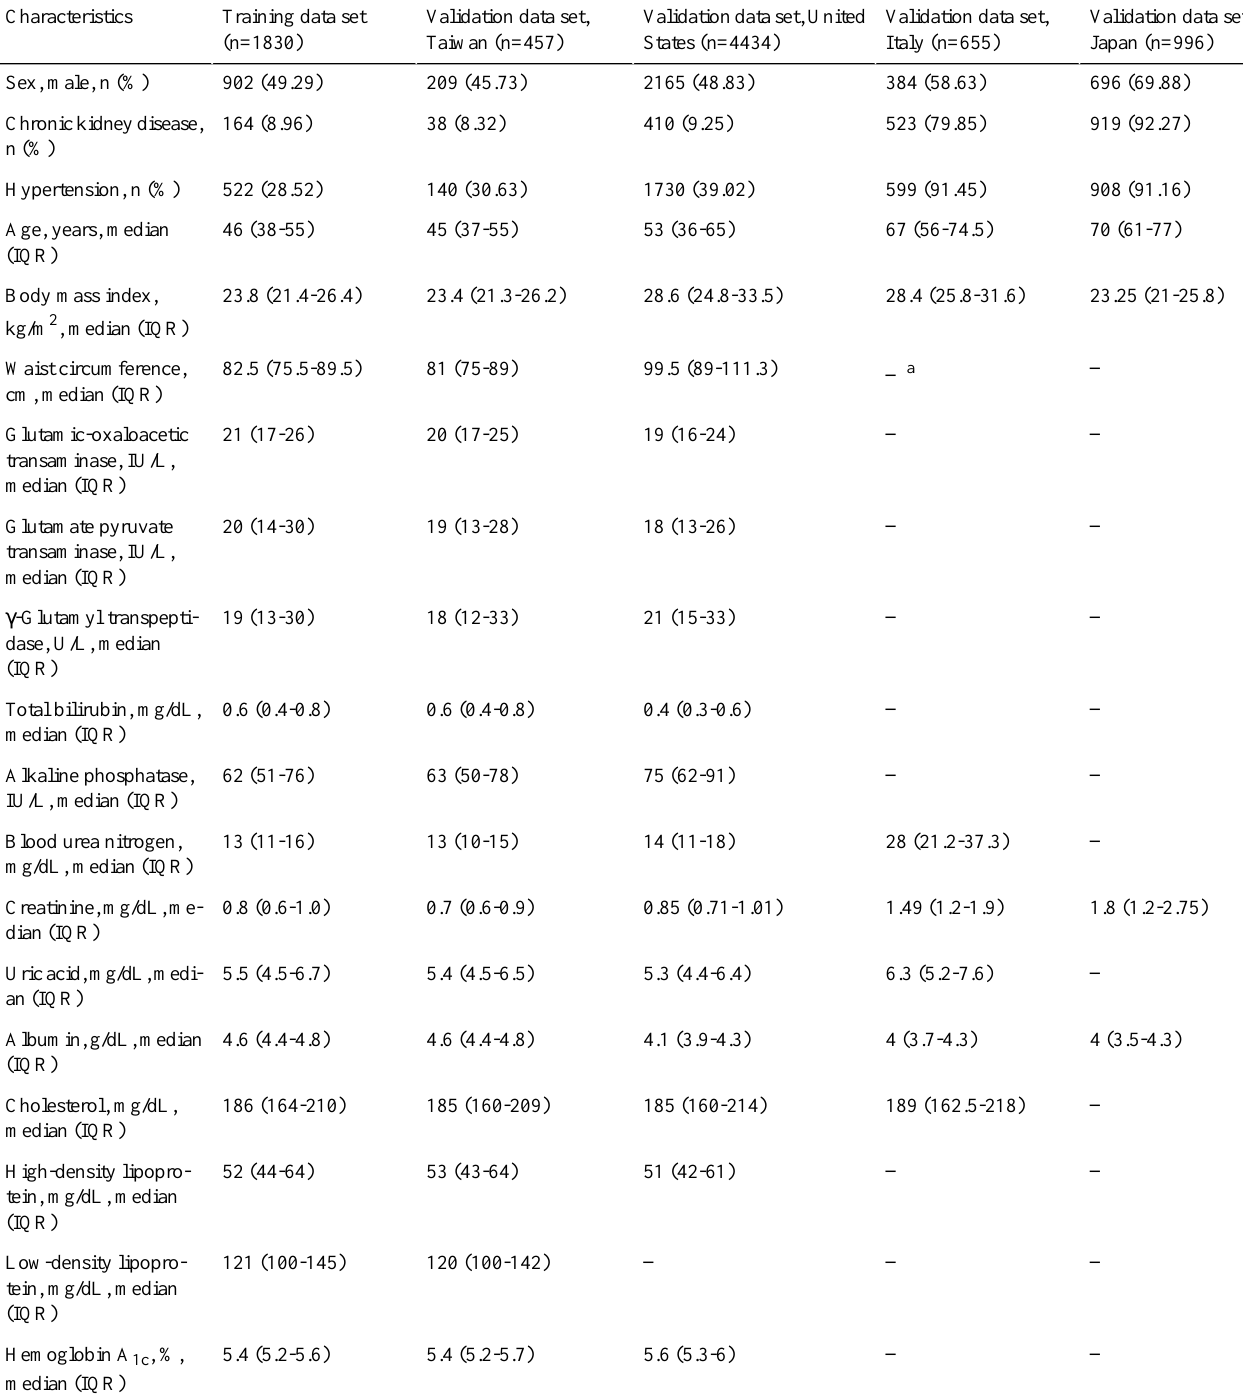
Table 3. Characteristics of participants in the training and validation data sets for chronic kidney disease.